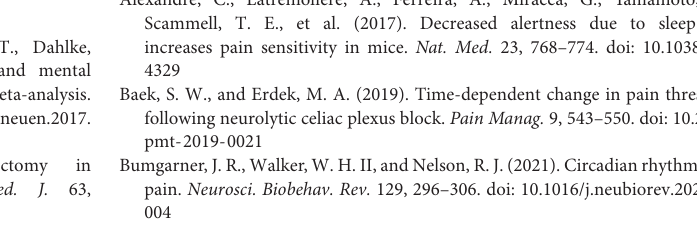
Supplementary Figure 1 | The scatter diagrams of the values of pressure pain threshold (A) , pressure pain tolerance (B) , cold pain threshold (C) , and cold pain tolerance (D) at six time points in a day (08:00, 12:00, 16:00, 20:00, 00:00, 04:00). Supplementary Figure 2 | The scatter diagrams of the values of average skin sympathetic nerve activity (A) , mean arterial pressure (B) , heart rate (C) , peripheral vascular resistance (D) , and cardiac output (E) at six time points of the day (08:00, 12:00, 16:00, 20:00, 00:00, and